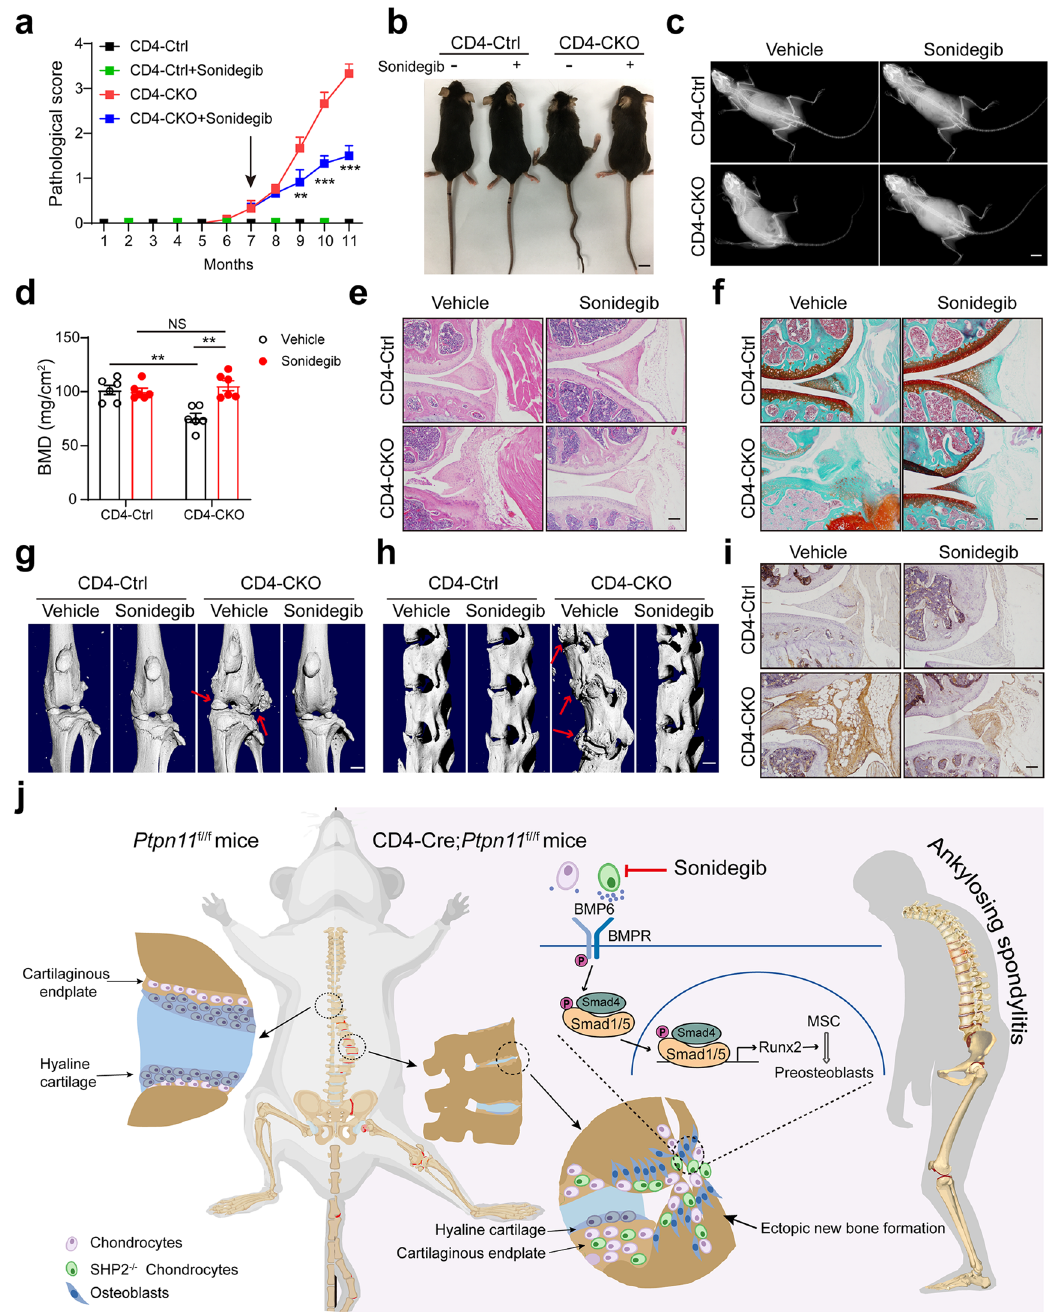
Fig. 8 Targeting chondrocyte retards AS progression in CD4-CKO mice. 7-month-old CD4-CKO mice and CD4-Cre littermates were orally gavaged with Smo inhibitor, sonidegib (100 mg/kg) for 4 months. a Pathological score ( n = 6). b Gross images. c X ‐ ray images. ( b and c ) Scale bars: 1 cm. d Femur bone mineral density (BMD). ( n = 6) e H&E staining of knee joints. f SOFG staining of knee joints. g and h μ -CT radiographs of knee joint ( g ) and spine ( h ) of 11-month-old mice. Arrows show ectopic new bone formation. Scale bars: 2.5 cm. i Immunohistochemical staining of pSmad1/5 protein levels in knee joint of 11-month-old mice. e , f , i Scale bars: 100 μ m. a , d Data are presented as mean ± SEM. ** p < 0.01, *** p < 0.001, determined by two-tailed Student ’ s t -test. b , c , e – i Da t a are representative of three independent biological replicates. j The mechanism of AS-like bone disease in CD4-CKO